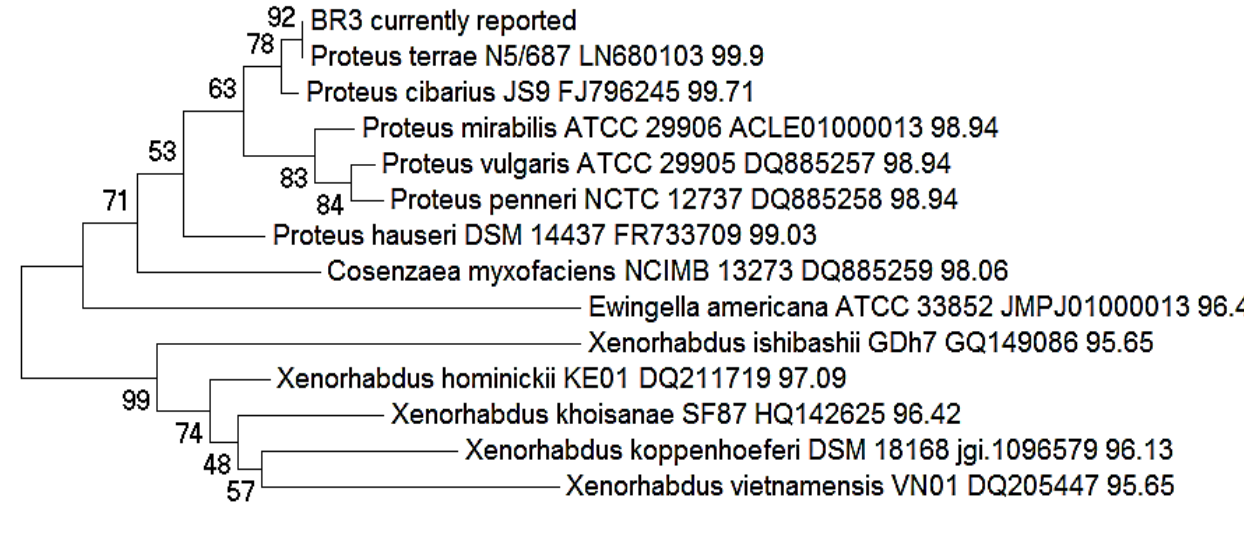
Figure 4. A total of 1.2% agarose gel electrophoresis of plasmid preparation from bacterial isolates